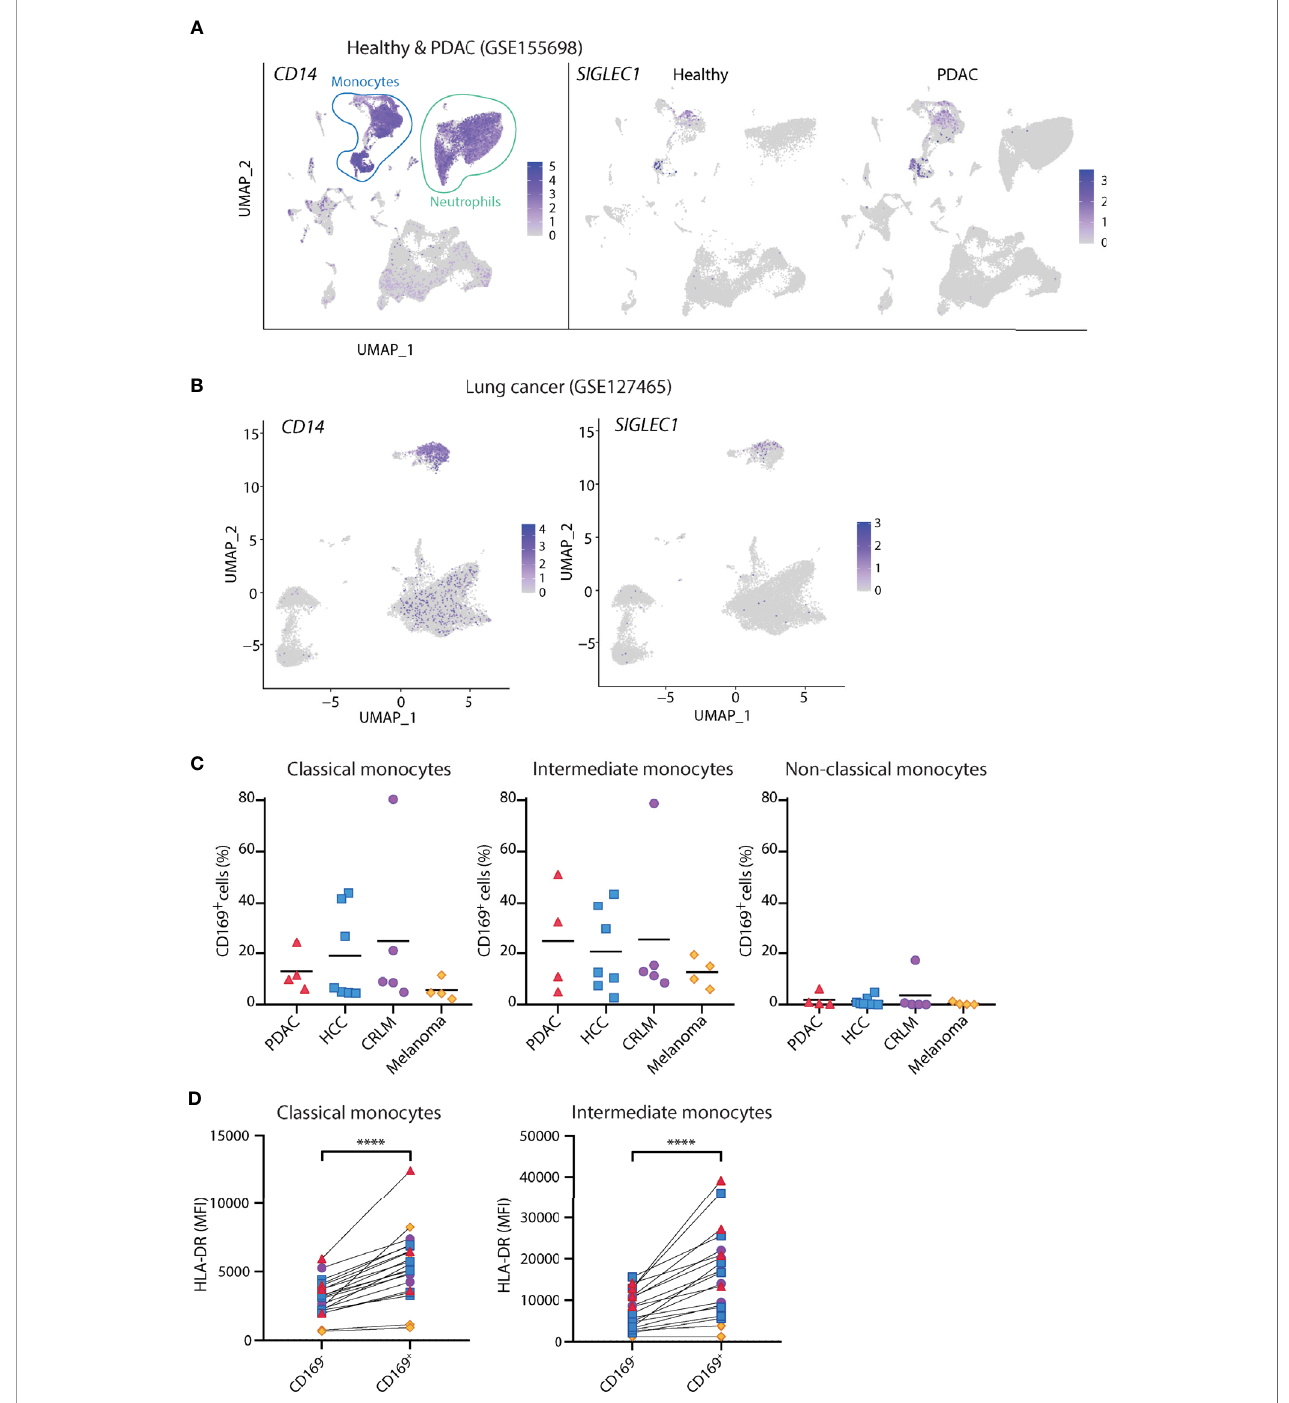
FIGURE 3 | CD14 + CD169 + monocytes are present in cancer patients. (A) Analysis of public scRNA-seq dataset of PBMCs from PDAC patients ( n = 12) and healthy controls ( n = 4) using Seurat algorithm and projected onto UMAP space where cell types are indicated. The expressions of CD14 and SIGLEC1 are visualized on UMAP. (B) Analysis of public scRNA-seq dataset of PBMCs from patients with lung cancer ( n = 7) using Seurat and UMAP clustering. The expression of SIGLEC1 and CD14 are shown. (C) Percentage of CD169 + cells within classical (CD14 + CD16 - ), intermediate (CD14 + CD16 + ), or non-classical (CD14 - CD16 + ) monocytes in patients with pancreatic ductal adenocarcinoma (PDAC, n = 4), hepatocellular carcinoma (HCC n = 7), colorectal liver metastasis (CRLM, n = 4), and melanoma ( n = 4). Monocytes were gated on live, HLA-DR + Lin(CD3/CD19/CD56) – cells. (D) Expression of HLA-DR between CD169 + and CD169 - classical or intermediate monocytes in cancer patients. Paired t-tests were used. ****P <